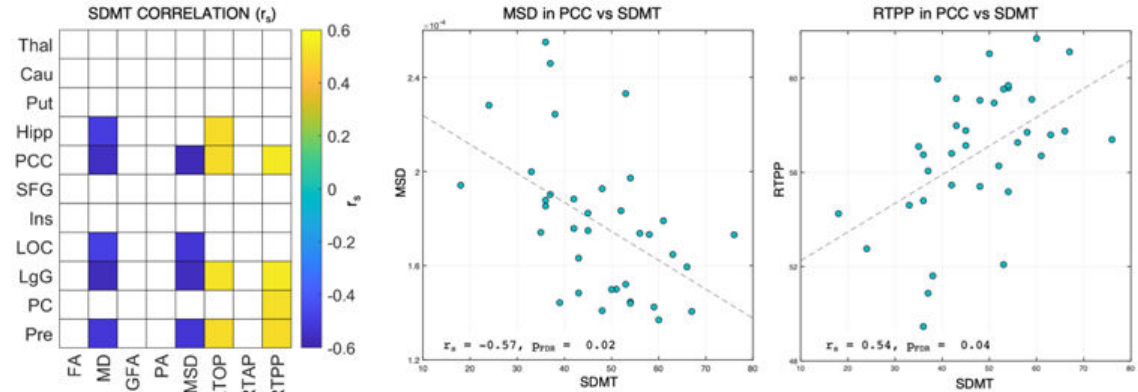
Figure 2. Spearman correlations (r S values, p FDR < 0.05) between each regional microstructural index value and SDMT scores (left). Significant associations are color-coded, while white squares indicate no significant associations. Scatter plots representing the associations between SDMT scores with MSD (center) and RTPP (right) values in the PCCare also reported. Legend. SDMT = Symbol Digit Modalities Test; Thal = thalamus; Cau = caudate; Put = putamen; Hipp = hippocampus; PCC = posterior cingular cortex; SFG = superior frontal gyrus; Ins = insula; LOC = lateral occipital cortex; LgG = lingual gyrus; PC = pericalcarine cortex; Pre = precuneus; FA = fractional anisotropy; MD = mean diffusivity; GFA = generalized fractional anisotropy; PA = propagator anisotropy; MSD = mean square displacement; RTOP = return to the origin probability; RTAP = return to the axis probability; RTPP = return to the plane